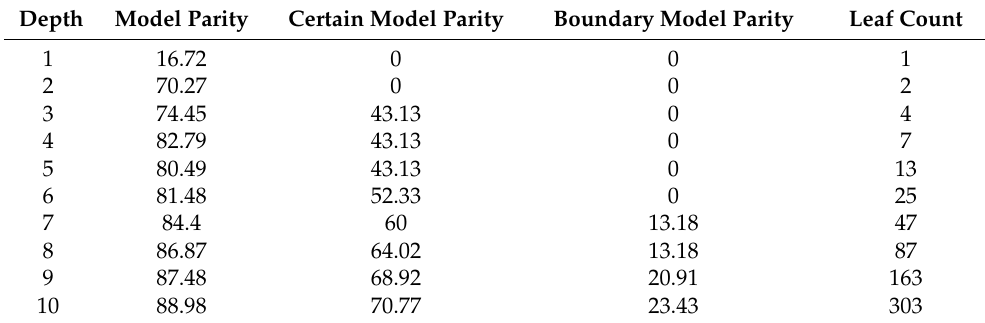
Table 9. Evaluation of the interpretable models for the Diabetes dataset generated by TRE-PAN at depths ranging from 1 to